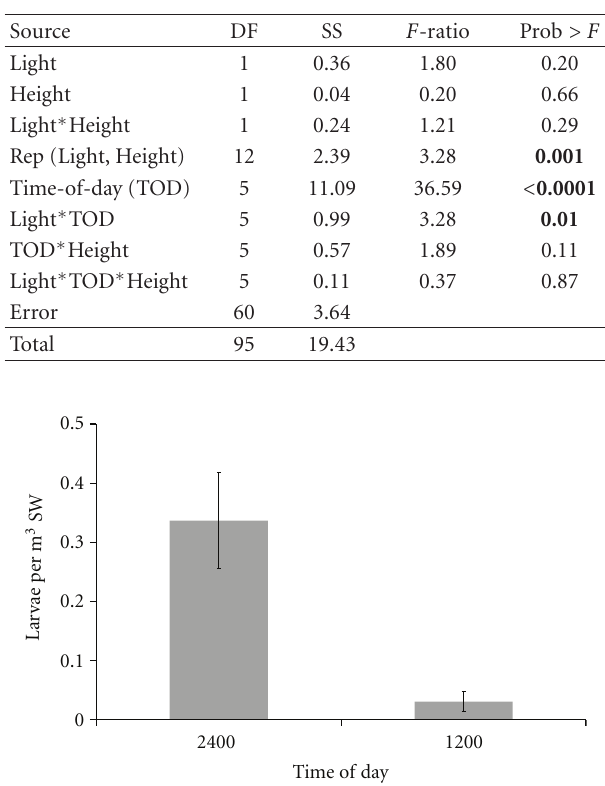
Table 2: Three-way ANOVA testing for e ff ect of light, time-of- day and column height on Kelletia kelletii diel vertical migratory behavior. DF: degrees of freedom, SS: sum of squares, Rep: replicate. Rep was treated as random. Bold results indicate significance.